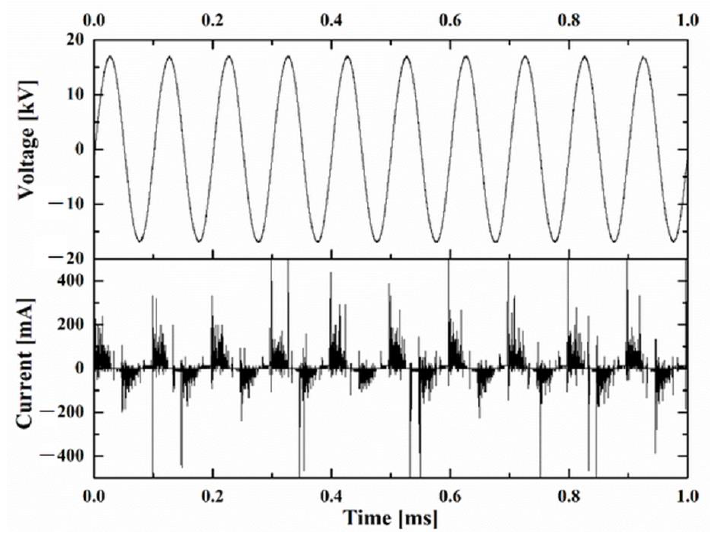
Figure 3. Discharge voltage and current waveforms. The names and description of the pristine and modified PI samples are given in Table 1. Table 1. The names and descriptions of the polyimide